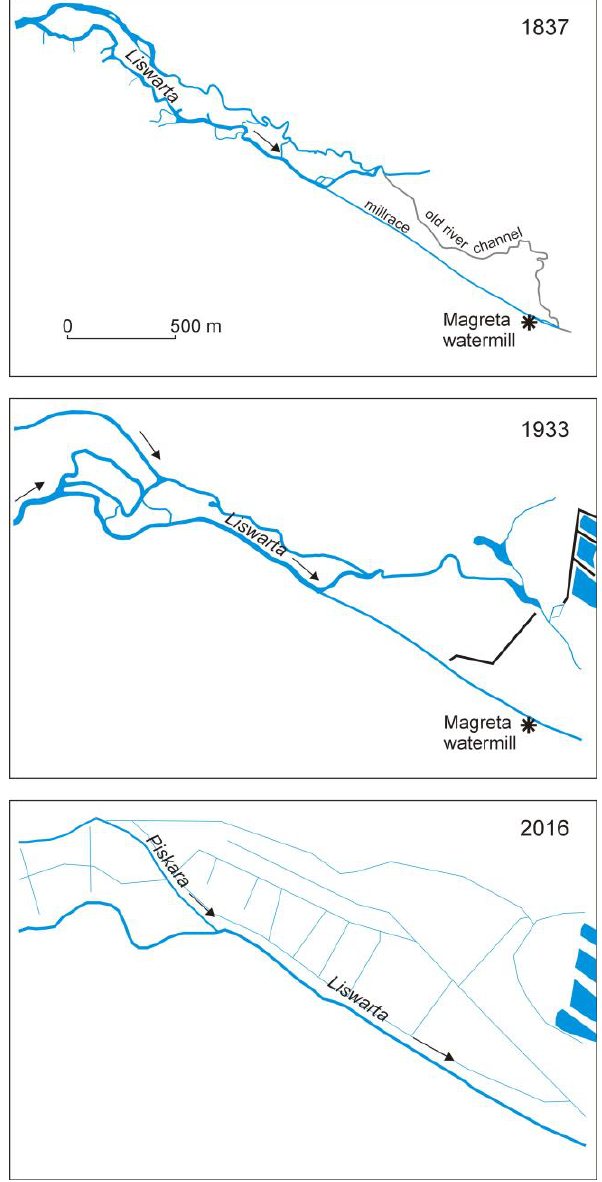
Fig. 6. Changes to the River Liswarta channel in the vicinity of the Magreta mill (own